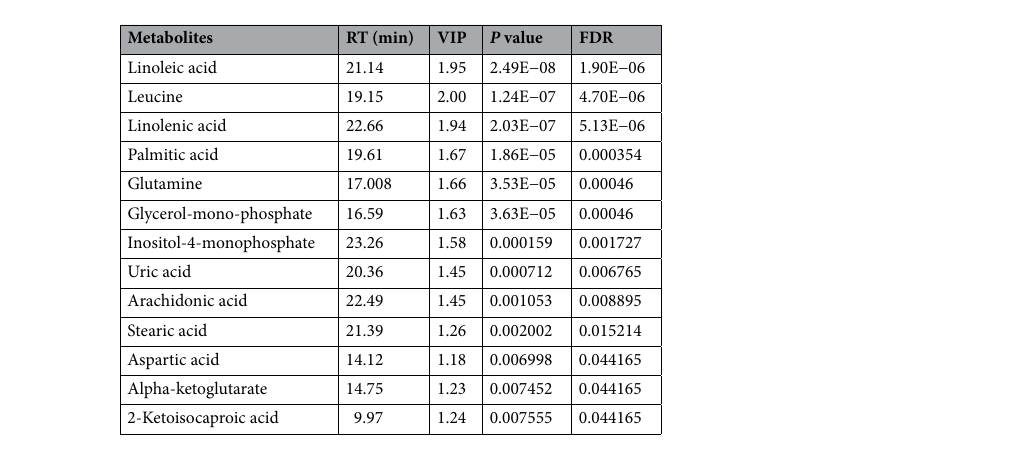
Table 2. Substantially altered metabolites between MTC and healthy groups using t test analysis. FDR false discovery rate, RT retention time, VIP variable importance in the projection. P values are from the student t test which considered < 0.05 statistically